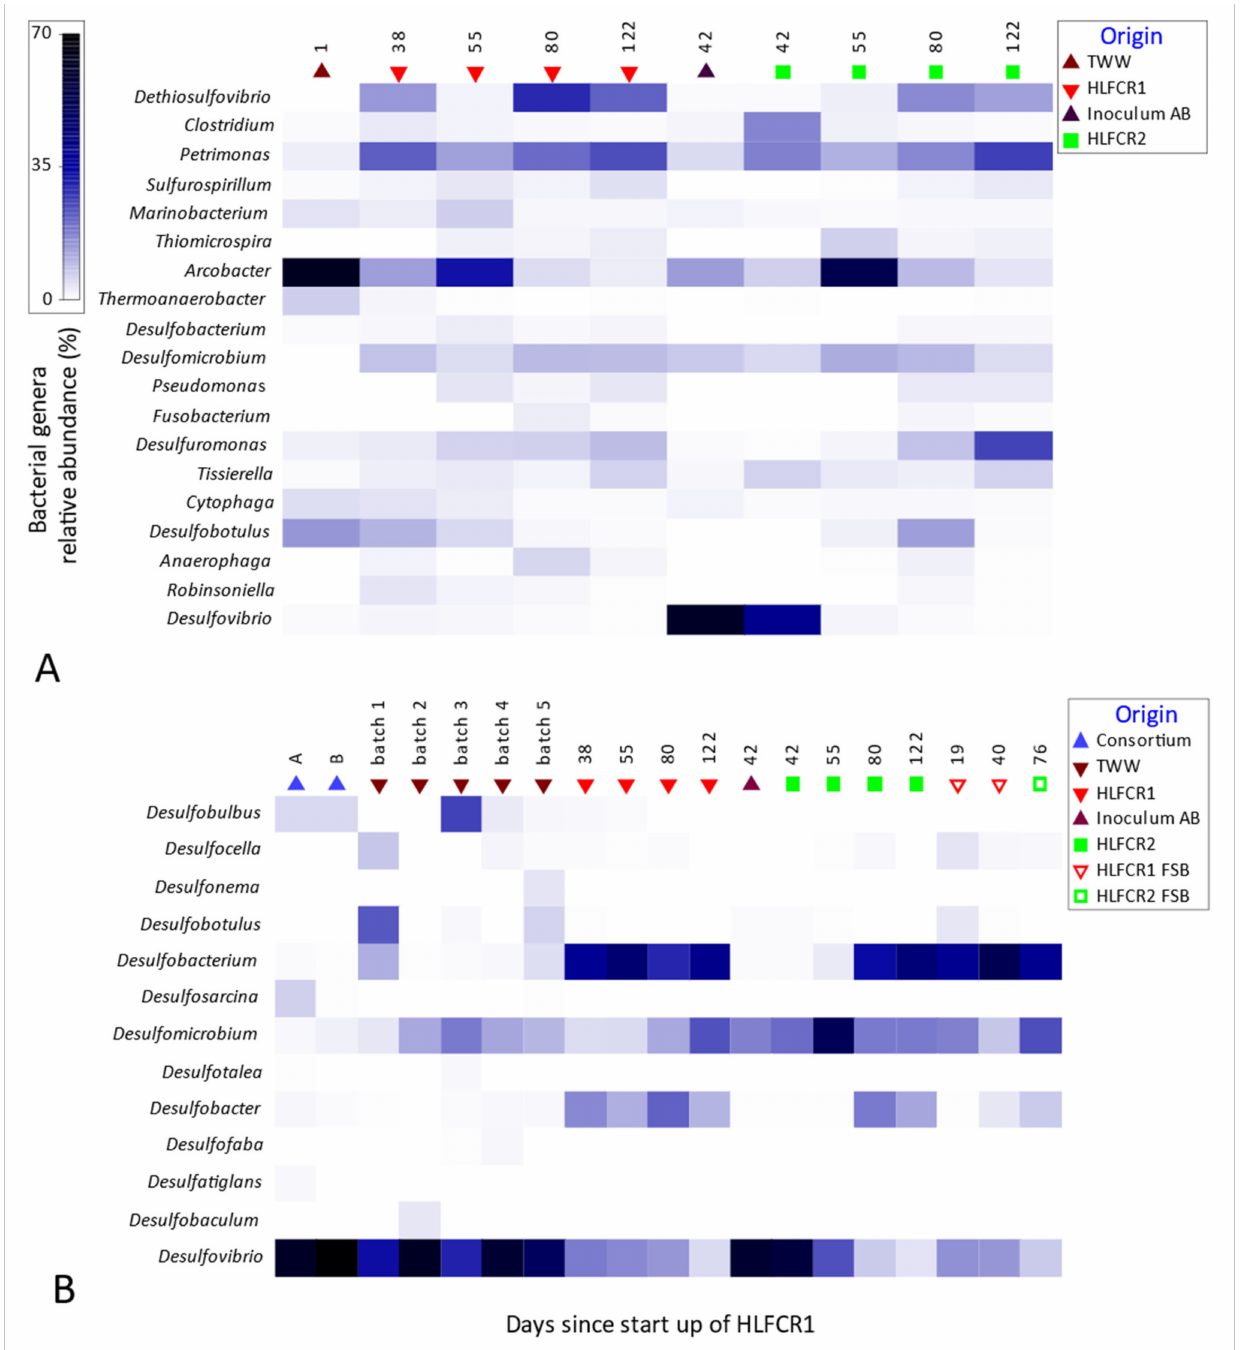
Figure 7. Shadeplot of the most abundant bacterial ( A ) and sulfite reducing ( B ) bacterial genera determined using 16S rRNA gene and dsrB primer sets,